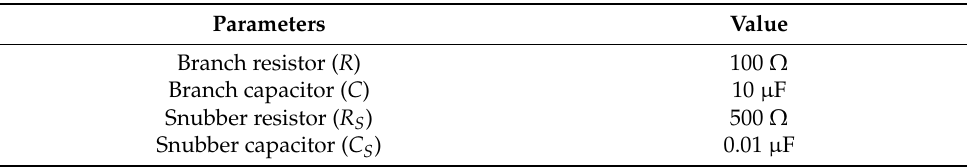
Table 1. Parameters of the proposed DC breaker.